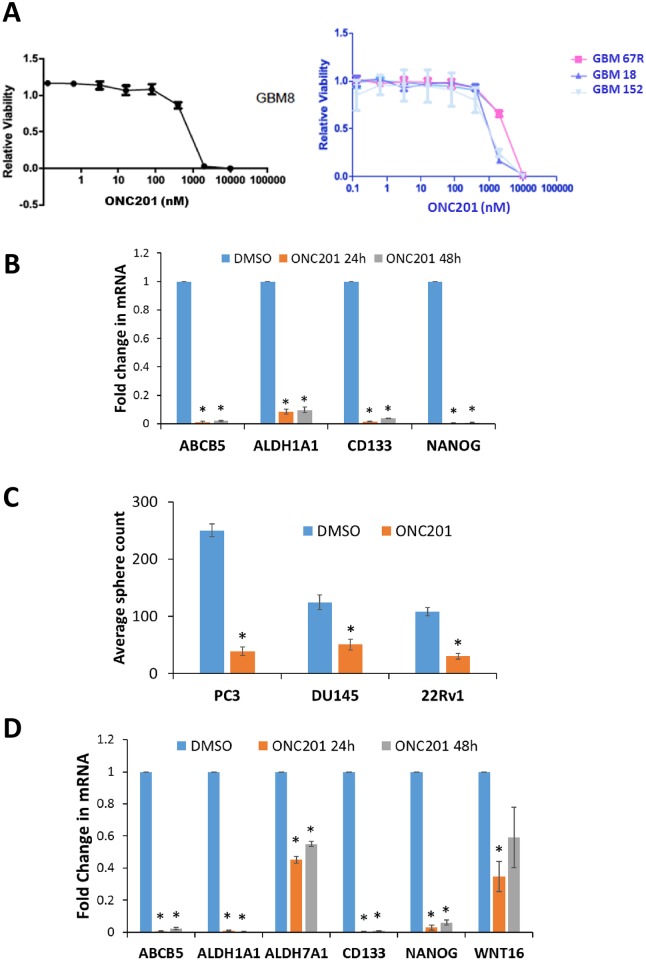
ONC201 targets CSCs in prostate and glioblastoma tumors.(A) Effect of indicated concentrations of ONC201 (72 h) on viability of newly diagnosed (GBM8, GBM18) and recurrent (GBM67R, GBM 152) glioblastoma cells in 3D neurosphere culture. (B) qRT-PCR for indicated stem cell-related genes in DMSO/ONC201-treated (5 μM, 24 h/48 h, n = 3) SNB19 cells. * indicates p < 0.0002 relative to DMSO. (C) Effect of DMSO/ONC201 (5 μM, 72 h, n = 3) on tumor sphere formation of indicated prostate cancer cell lines. * indicates p < 0.025 relative to DMSO. (D) qRT-PCR for indicated stem cell-related genes in DMSO/ONC201-treated (5 μM, 24 h/48 h, n = 3) DU145 cells. * indicates p < 0.04 relative to DMSO.